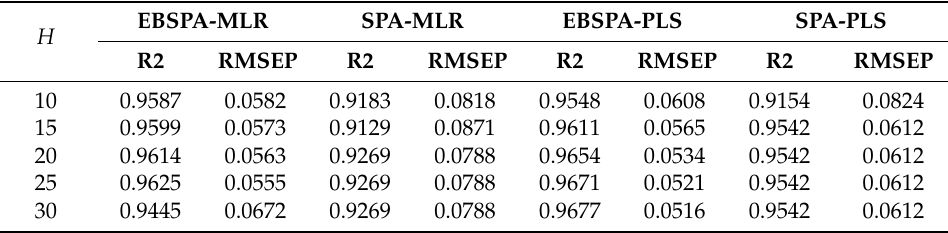
Table 3. Prediction performance for various H .